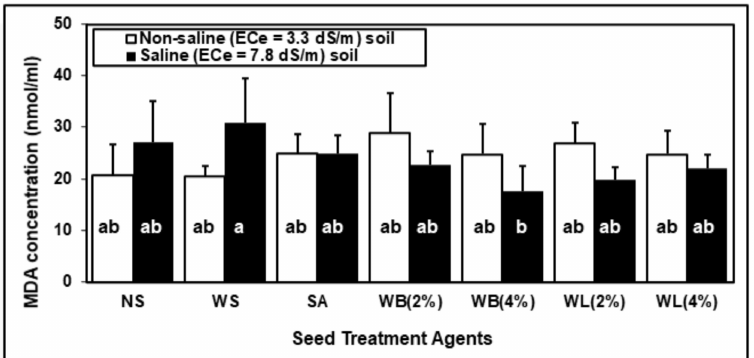
Figure 6. Changes in MDA concentration of 2-week-old soil-grown maize ( Zea mays cv. Caramelo) shoots in response to salinity (non-saline: EC e = 3.3 dS/m; saline: EC e = 7.8 dS/m) and different seed treatments (NS, non-soaked; WS, water-soaked; SA, salicylic acid (0.5 mM); WB, willow bark extract (2% or 4% w / v ); WL, willow leaf extract (2% or 4% w / v